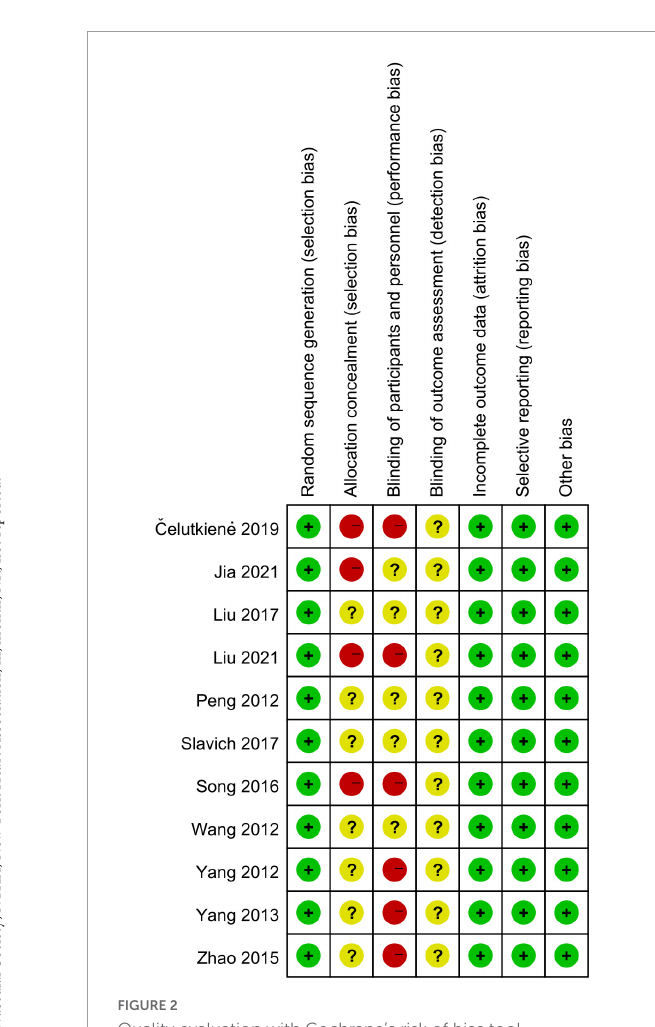
FIGURE2 Quality evaluation with Cochrane’s risk of bias